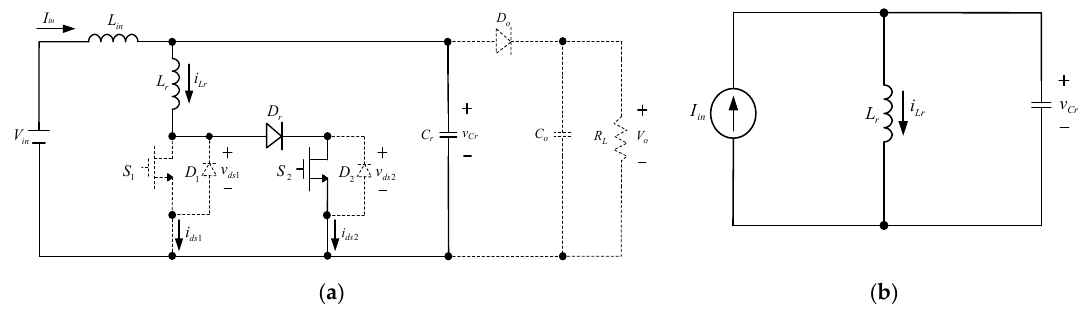
Figure 6. ( a ) Current flow in state 3; ( b ) Equivalent circuit of ( a ).